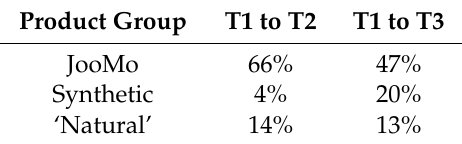
Table 3. Percentage change in richness for all product